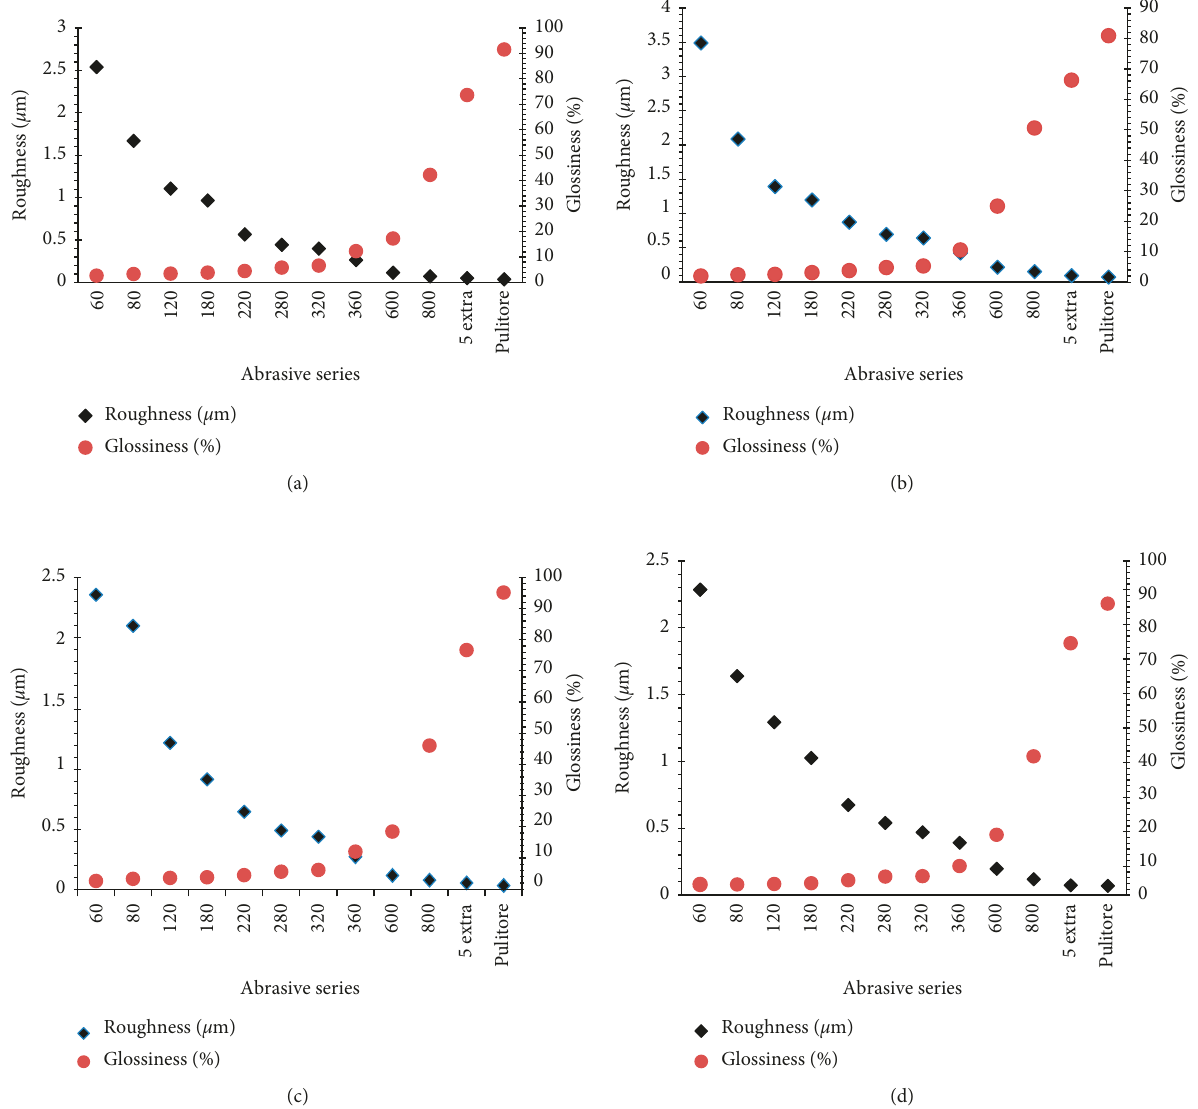
Figure 3: Surface roughness and glossiness values versus abrasive number for (a) Adara, (b) Emperador, (c) Crema nera, and (d) Sand wave.